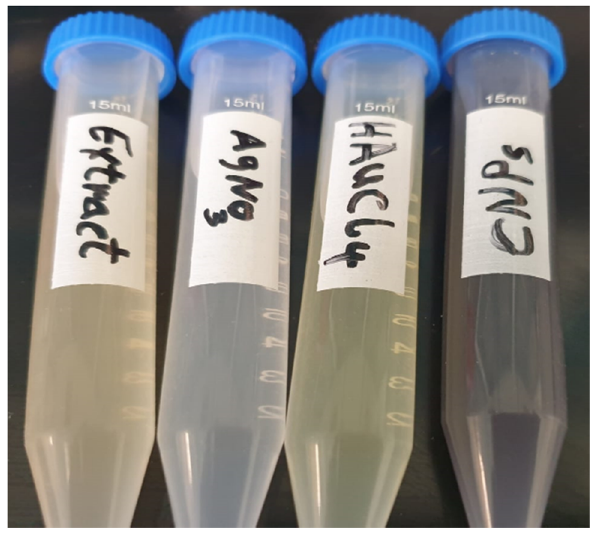
Figure 1: Change of color in silver and gold